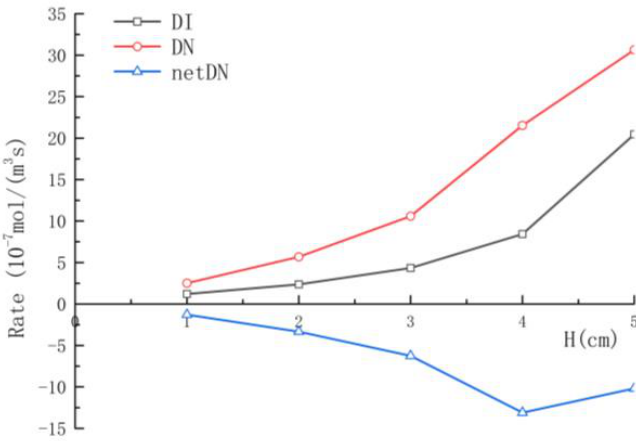
Figure 8. Variations in the mean spatial reaction rates with height.